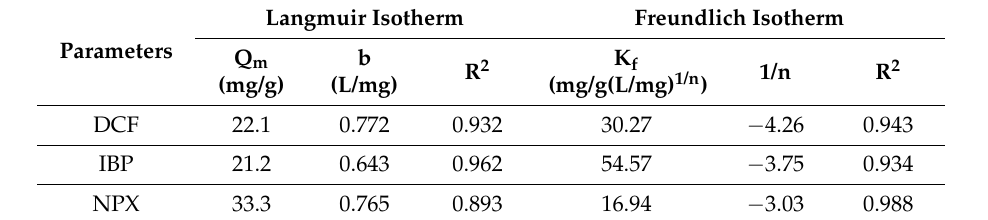
Table 4. Langmuir and Freundlich isotherms study for DCF, IBP, and NPX removal by CMCAB. Langmuir Isotherm Freundlich Isotherm Parameters